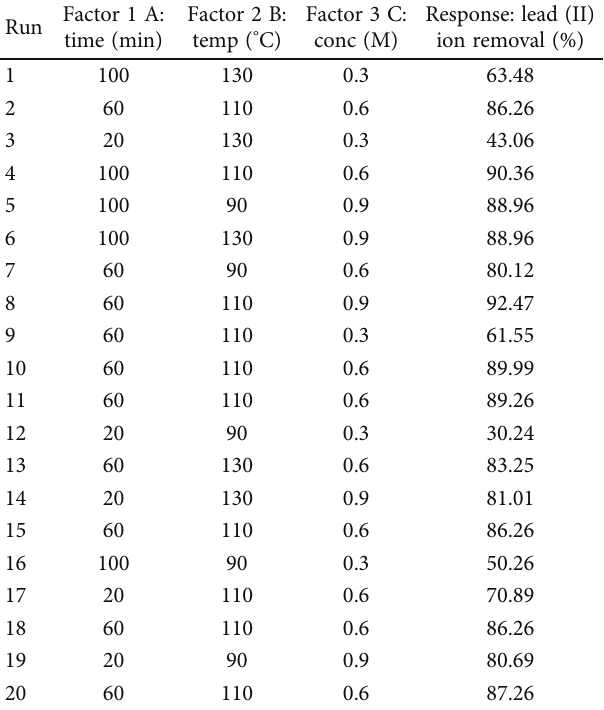
Table 4: CCD experimental design matrix and results of corresponding response